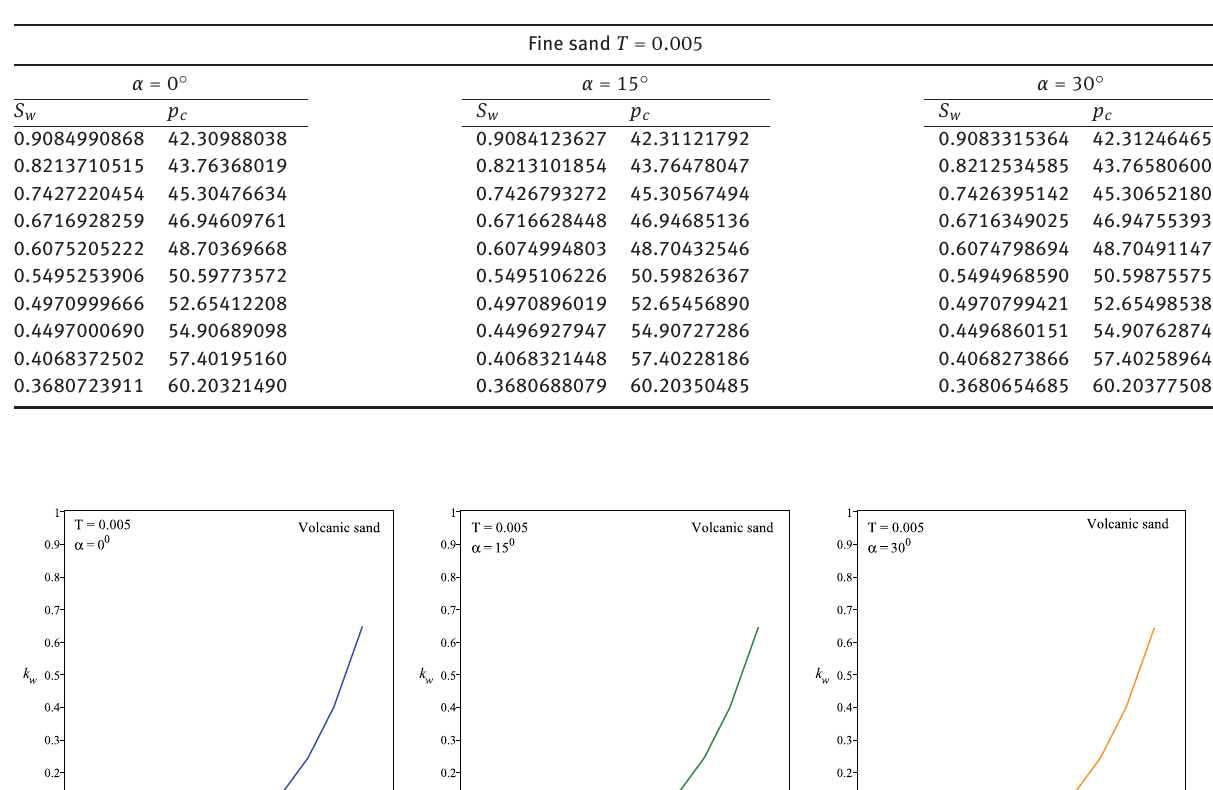
Table 6: Comparison of the numerical values for saturation vs. capillary pressure in heterogeneous porous media for fine sand at different inclined plane α = 0 ◦ , 15 ◦ , 30 ◦